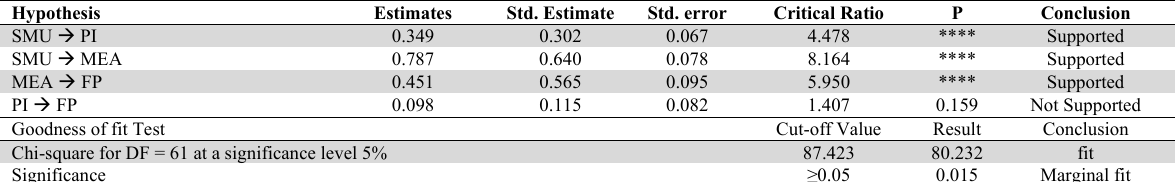
Hypothesis Testing